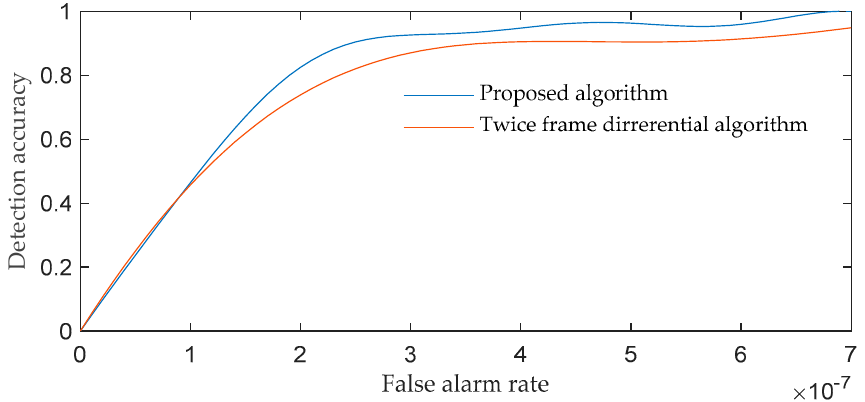
Figure 12. The receiver operating characteristic curves (ROC) of the proposed algorithm and the twice frame differential algorithm.